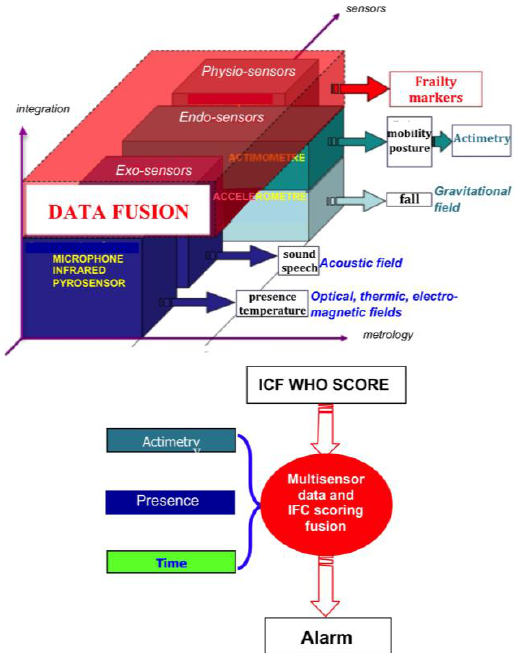
Figure 3. Top: data fusion of physiological and physical exo- and endo-sensors detecting gravitational, acoustic, optical, thermal and electromagnetic fields. Bottom: profiling from multi-sensor data fusion and ICF scoring, in order to trigger an alarm in the case of a life-threatening risk.